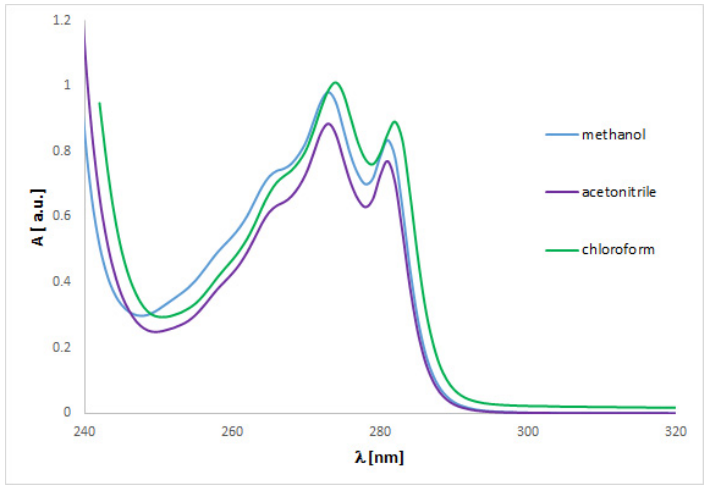
Figure 10. Experimental UV-vis spectrum of isoconazole 1 registered in methanol, acetonitrile and chloroform at 0.5 mg/mL.